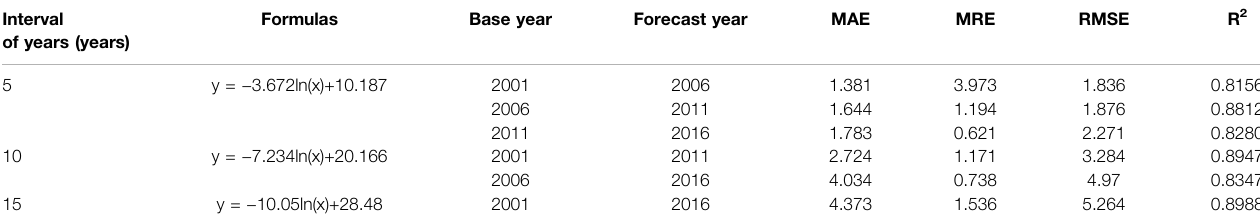
TABLE 5 | Error analysis table of the relationship between increase rate of the soil salt content and the groundwater buried depth. Interval of years